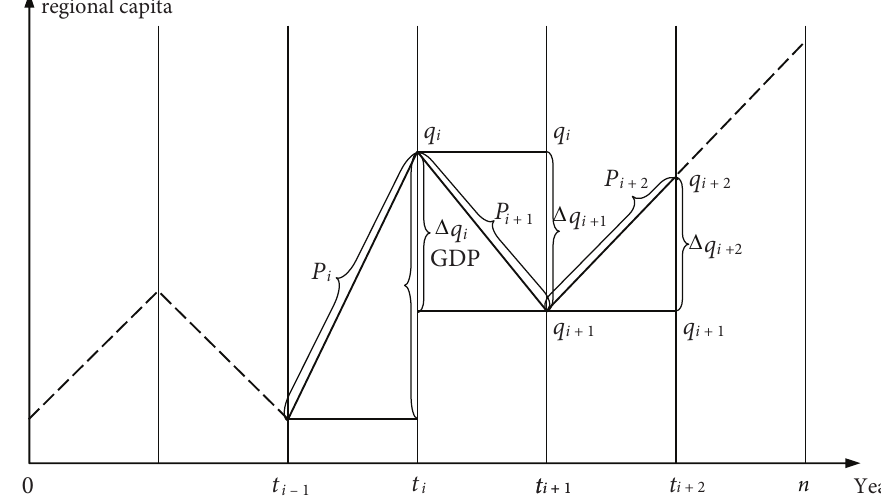
Figure 2. Differences in the economic development of a region of a country over time periods (differences in the economic development values over the period ∆ qi − i − 0 ) (source: completed by authors based on Ginevičius et al.,